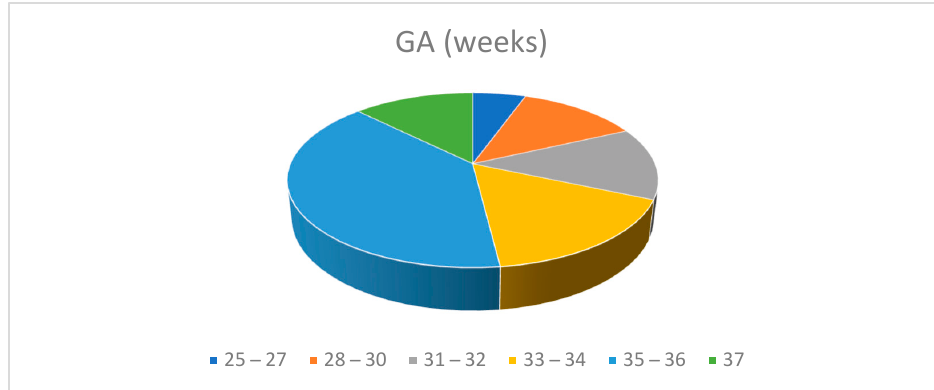
Figure 5. Population data. Distribution by Gestational Age. The age range of the mothers was 22 to 46 years. A 44.9% were under 36, and 32 (55.1%) were over 36. Statistical comparison was made between these two age categories (Table 6). Table 6. Maternal Age.